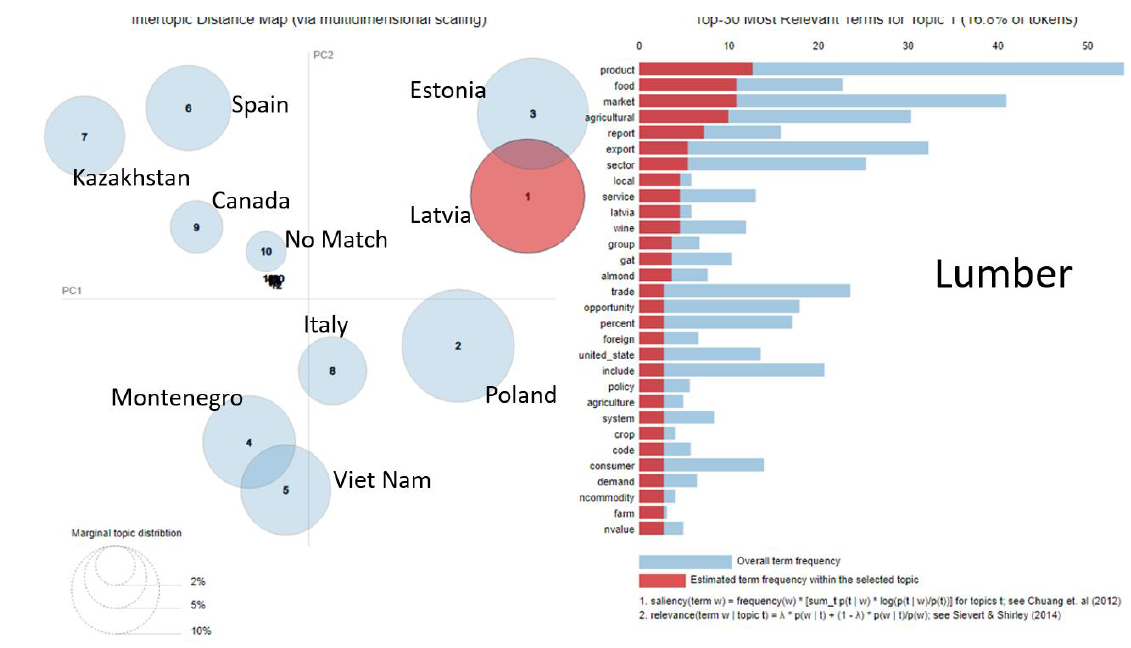
Figure 5. Lumber: Top 3 Countries.